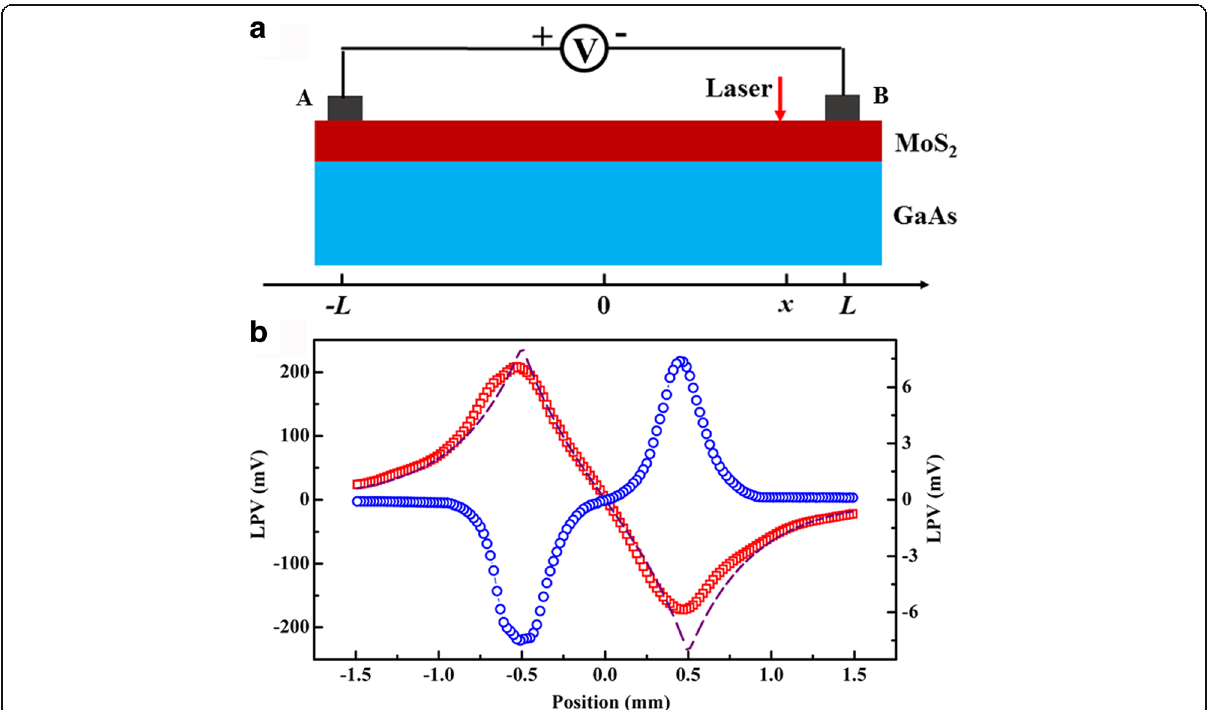
Fig. 4 a Schematic circuit for the measurement of the LPE. b LPE curves of the MoS 2 / n -GaAs and MoS 2 / p -GaAs heterojunctions, respectively